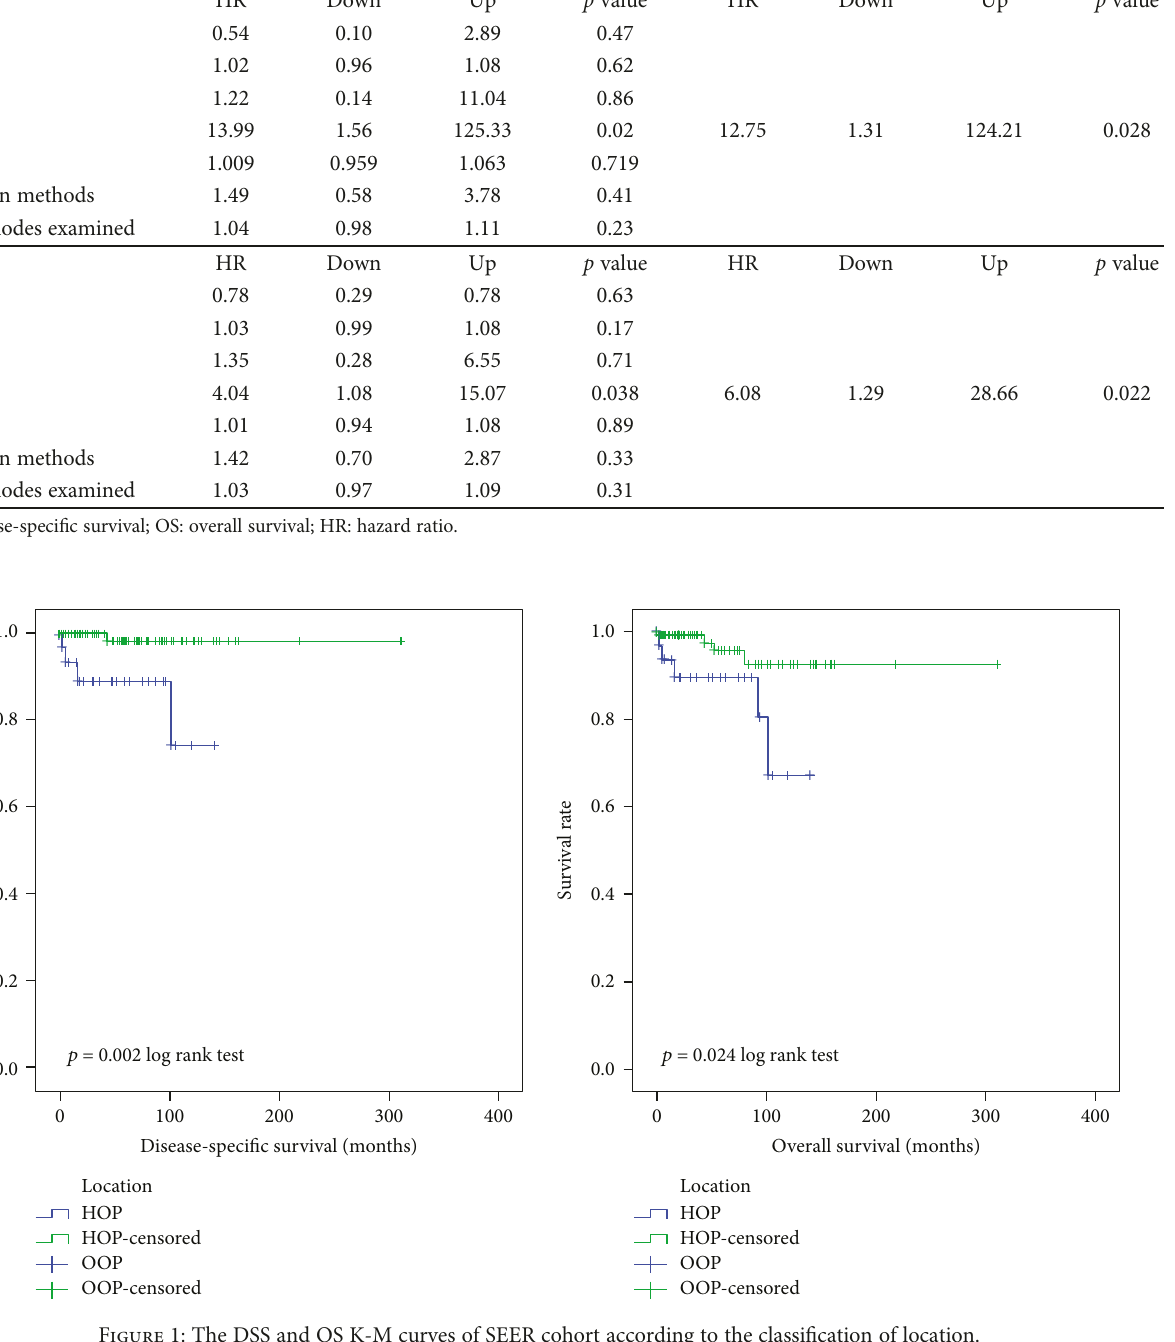
Table 3: Prognostic factors for DSS and OS in SEER cohort according to univariate and multivariate analysis. Survival